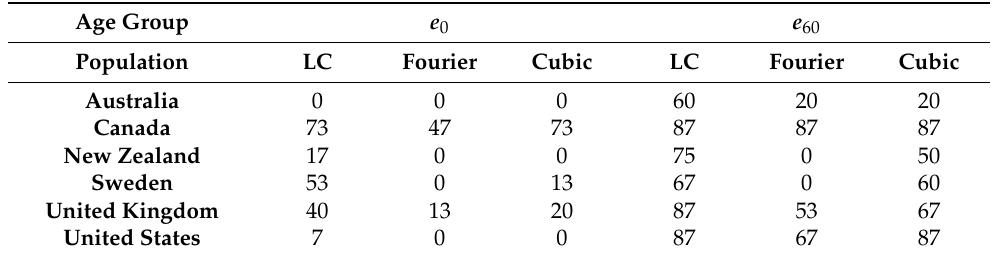
Table 3. Proportions (%) of observed life expectancies at ages 0 and 60 falling outside 95% prediction intervals, predicted over the last 15 years of the sample. Age Group e 0 e 60 Population LC Fourier Cubic LC Fourier Cubic Australia